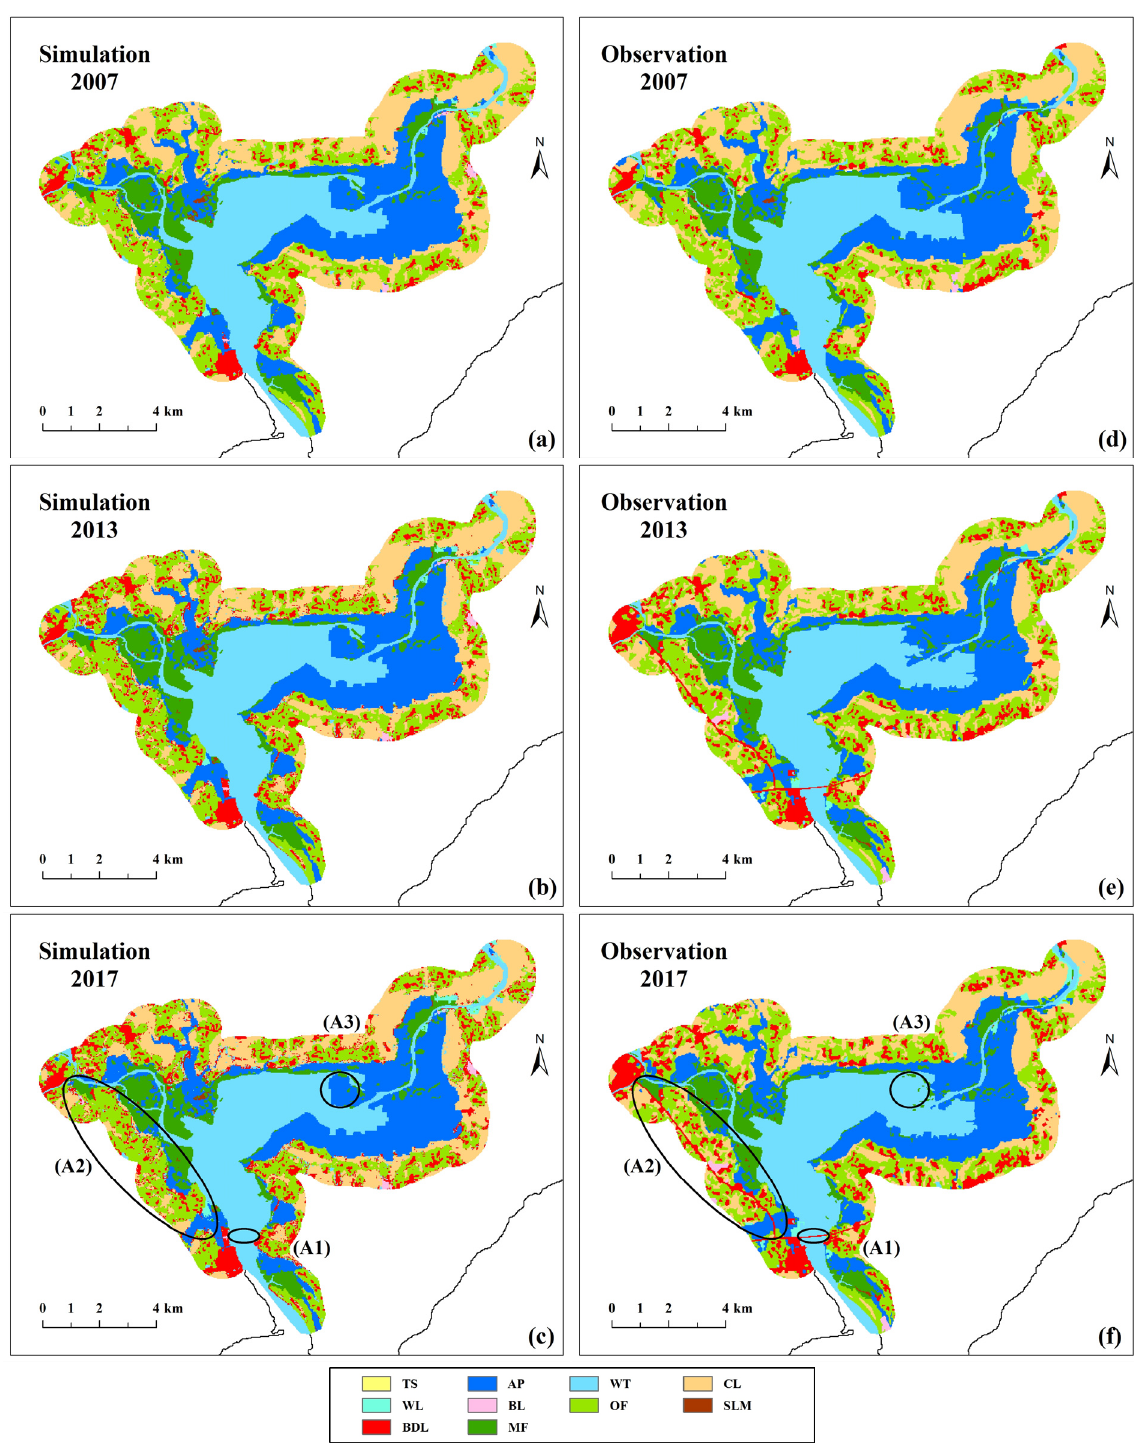
Figure 3. Comparison between simulation maps ( a )–( c ) and observation maps ( d )–( f ) for AutoRF.